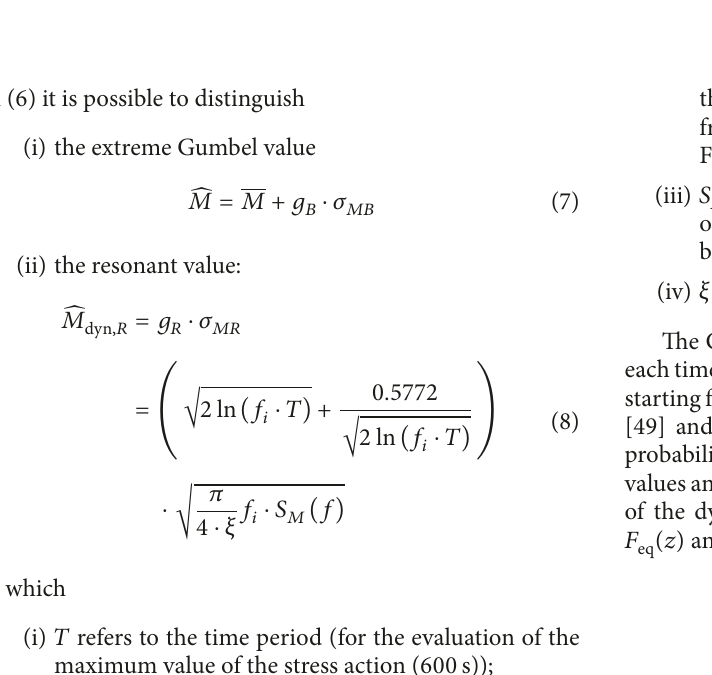
Figure 6: Time history of the acceleration (in 𝑦 -direction): (a) for 𝜉 = 1 % and (b) for 𝜉 = 4.0